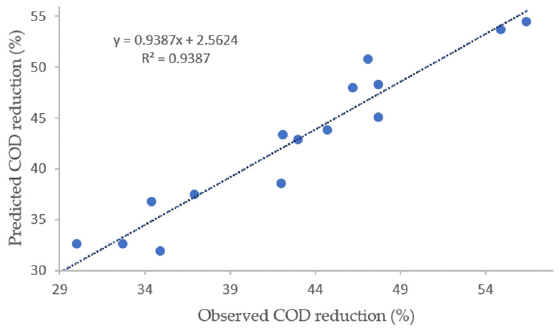
Figure 4. Observed vs Predicted value plot for COD reduction for solar photo-Fenton experiments in pre-treated leachate with PAC coagulant.